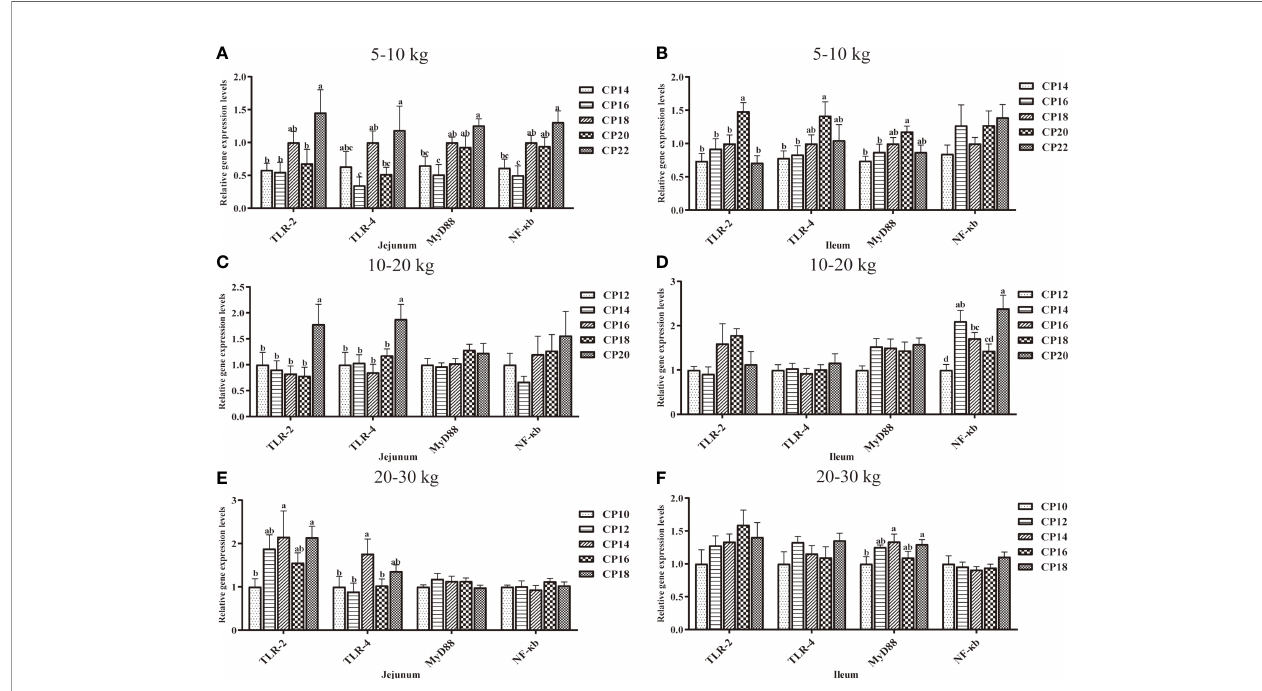
FIGURE 7 | Effects of dietary crude protein (CP) levels on the TLR-MyD88-NF- k B signaling pathway-related gene expression in the small intestinal mucosa of Huanjiang mini-pigs during 5 − 10 kg ( A , jejunum; B , ileum), 10 − 20 kg ( C , jejunum; D , ileum), and 20 − 30 kg ( E , jejunum; F , ileum)t growth stages. Data are presented as means ± SE ( n = 6 − 8 per group). Different superscript letters indicate signi fi cant differences among the fi ve groups ( P < 0.05). TLR, toll-like receptors; MyD88, myeloid differentiation factor 88; NF- k B, nuclear factor kappa